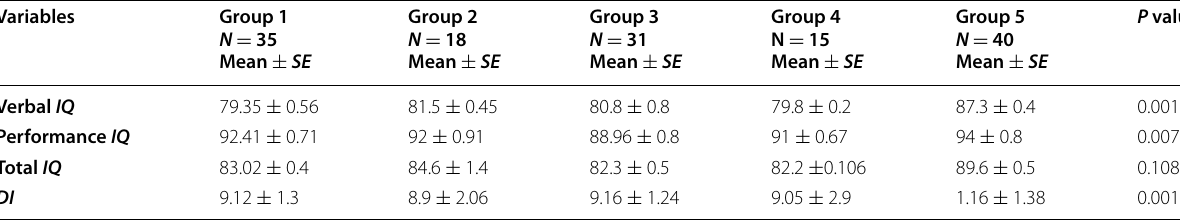
Group 1: carbamazepine, group 2: valproate, group 3: carbamazepine and clonazepam, group 4: valproate and clonazepam, group 5: epileptic patients without antiepileptic drugs (AEDs), *significant P value, DI Deterioration Index